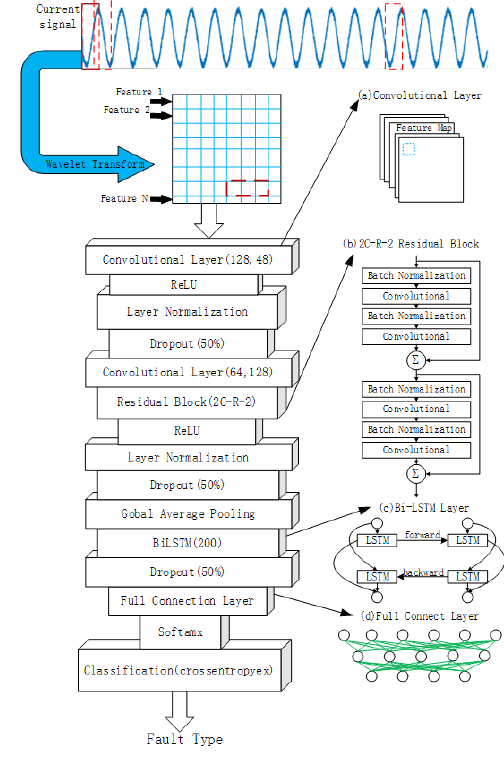
Figure 10. The proposed Res-BiLSTM Frame for Fault Classification of Driving Unit in Marine Electric Propulsion System. ( a ) Schematic diagram of the convolution layer ( b ) Structure of 2C-R-2 Residual Block ( c ) Structure of Bi-LSTM ( d ) Schematic diagram of full connect layer